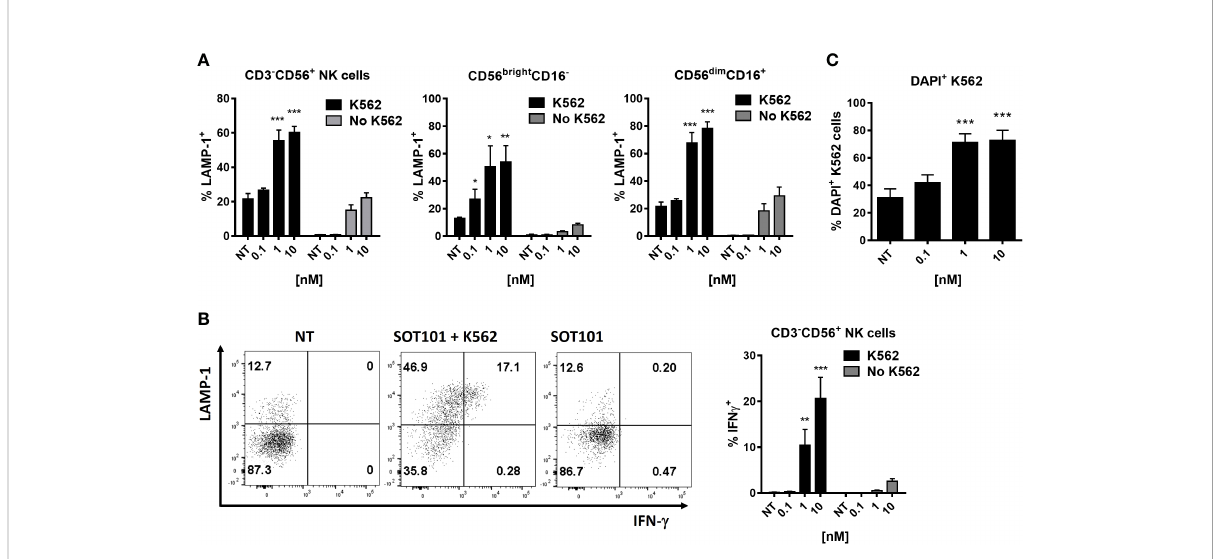
FIGURE 2 SOT101 induces cytotoxic and tumor cell-killing activity of human NK cell subtypes in vitro .PBMCs were pre-stimulated with 0, 0.1, 1 and 10 nM SOT101 for 3 days, then added to the target tumor cells DiD + K562 at E:T ratio 1:5. The cytotoxic activity was determined by (A) LAMP-1 degranulation on NK cells and their subpopulations and (B) by an intracellular IFN- g staining after 4h. (C) The percentage of killed DiD + DAPI + K562 cells was determined after 6 h by fl ow cytometry. Representative dotplots of LAMP-1 and IFN- g staining in NK cells are shown in (B) (NT – non-treated NK cells with K562; SOT101 + K562 – NK cells pre-stimulated with SOT101 at 1 nM with K562; SOT101 – NK cells pre-stimulated with SOT101 at 1 nM without K562). Data represent mean ± SEM from 4 healthy donors. The results were considered statistically signi fi cant if * p < 0.05, ** p < 0.01 or *** p <